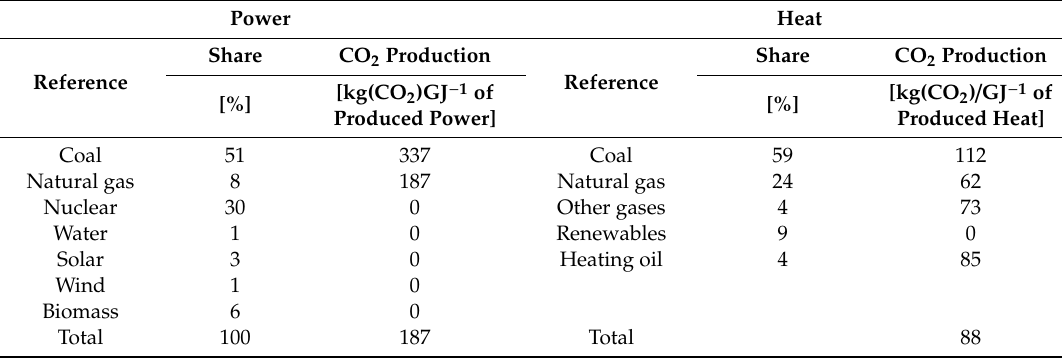
Table A2. The fuel mix for the power and heat industry in the Czech Republic (Slivka, 2011) [32].